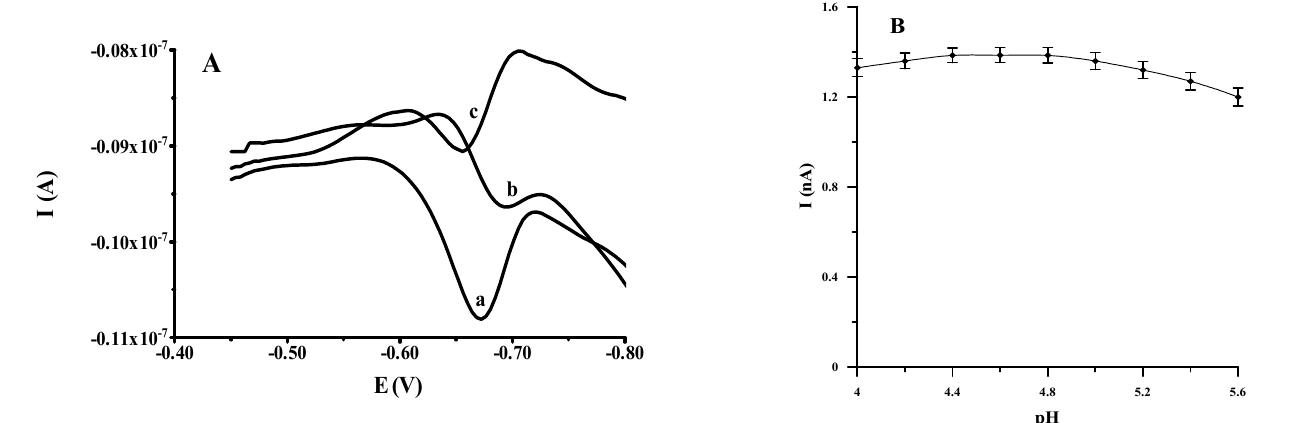
Figure 1. The AdSV voltammograms of 1 × 10 -8 mol L -1 V(V) obtained in the solution containing: 0.1 mol L -1 acetate buffer (a), 0.1 mol L -1 Britton-Robinson buffer (b) and 0.1 mol L -1 phosphate buffer (c) ( A ). The effect of pH of 0.1 mol L -1 acetate buffer on the AdSV voltammetric response of 1 × 10 -8 mol L -1 V(V) ( B ). The accumulation potential and time were -0.4 V and 60 s, respectively.